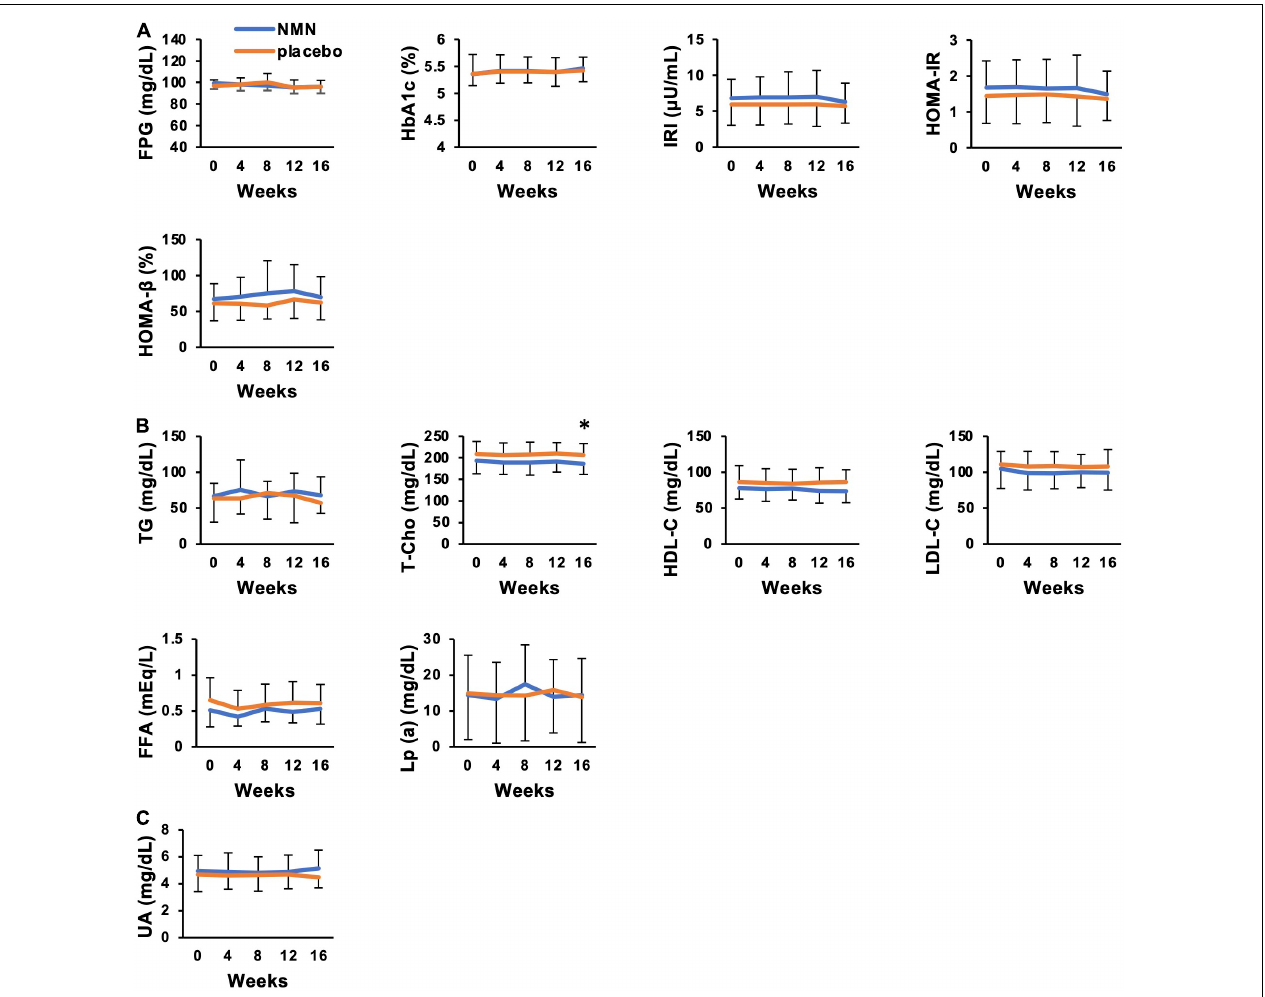
FIGURE 5 | Clinical metabolic effects of NMN oral administration were not apparent. Blood tests were performed every 4 weeks to evaluate glucose metabolism (A) , lipid metabolism (B) , and uric acid level (C) . Orange represents placebo group ( n = 15 at 0, 4, 8 weeks, n = 14 at 12, 16 weeks) and blue represents NMN group ( n = 15). Data are represented as mean ± SD. FPG, fasting plasma glucose; HbA1c, hemoglobin A1c; IRI, immunoreactive insulin; HOMA-IR, homeostasis model assessment-insulin resistance; HOMA- β , homeostasis model assessment-beta cell function; TG, triglyceride; T-cho, total cholesterol; HDL-C, high